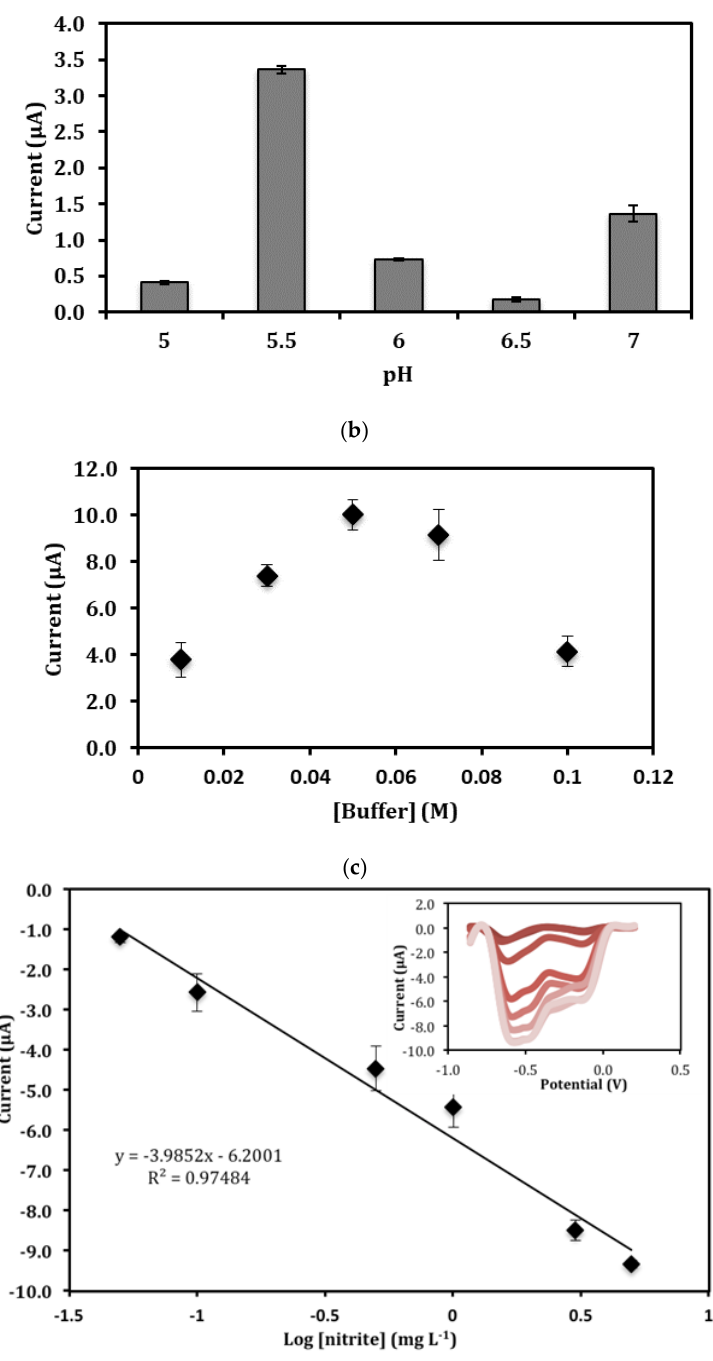
Figure 5. The differential pulse voltammograms of Hb-poly(nBA)-rGO-SPE in 0.05 M potassium phosphate buffer at different pHs ( a ). The DPV response of the Hb SPE in 0.05 m potassium phosphate buffer of different pHs ( b ) and buffer concentrations ( c ) containing 1 ppm nitrite at −0.6 V versus Ag/AgCl reference electrode. Calibration curve of the biosensor in the nitrite concentration range of 0.05–5 mg L −1 ( n = 3), the inset shows the DPV signals of the Hb-poly(nBA)-rGO-SPE from